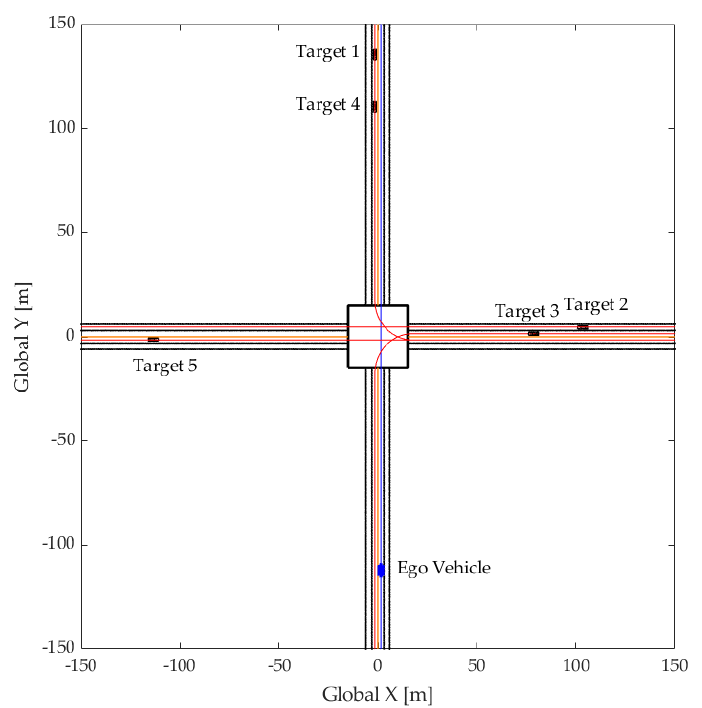
Figure 14. Example simulation scenario of Monte Carlo simulation.